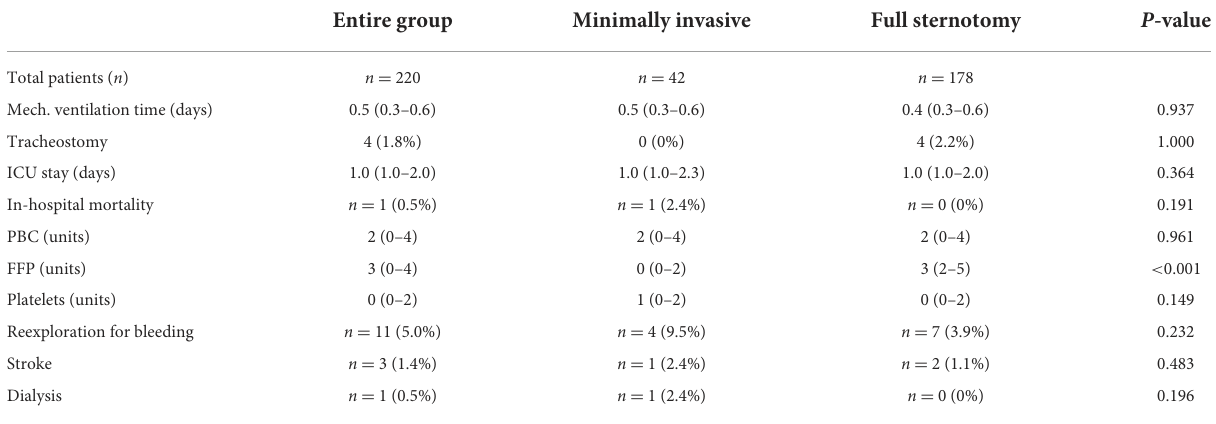
TABLE 3 Post-operative